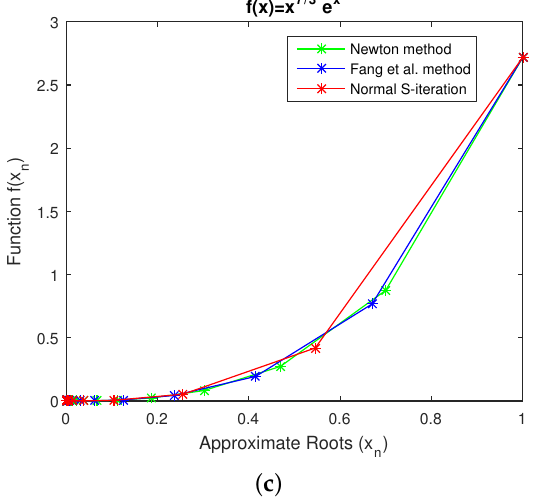
Figure 1. The graph using values of functions and roots: ( a ) Graph for f 2 ; ( b ) Graph for f 3 ; ( c ) Graph for f 5 . Case 2: Graph of the number of iterations and roots for f 2 , f 3 , and f 5